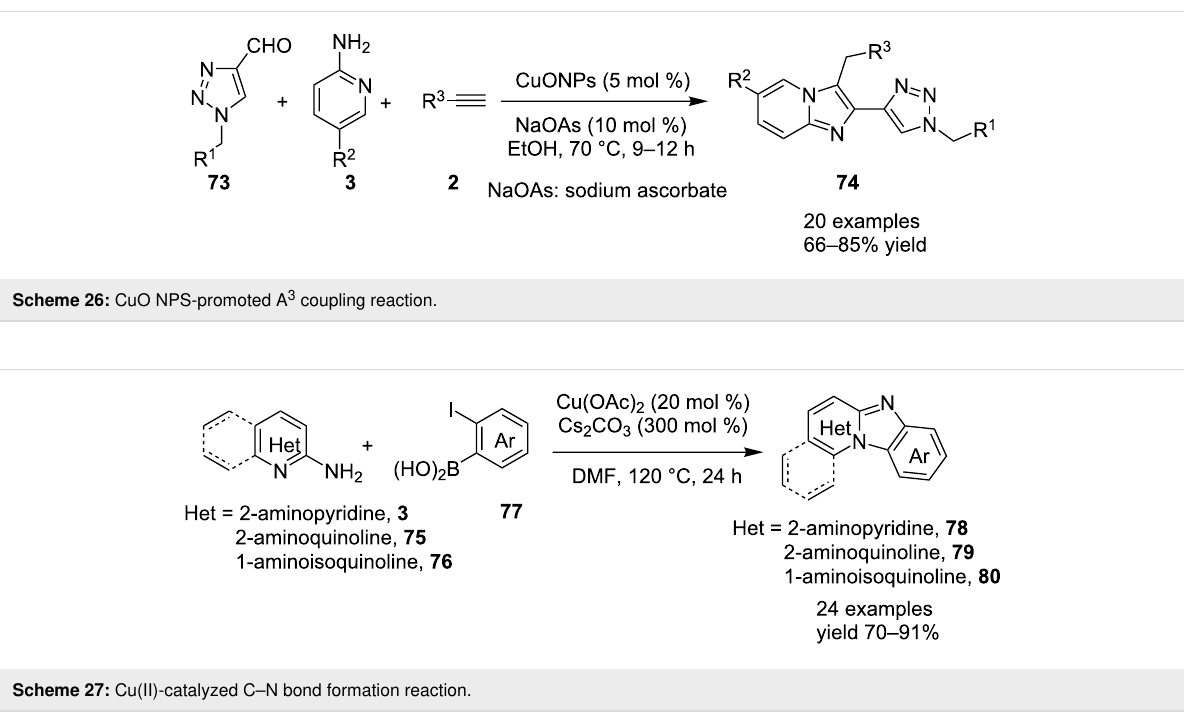
Scheme 27: Cu(II)-catalyzed C–N bond formation